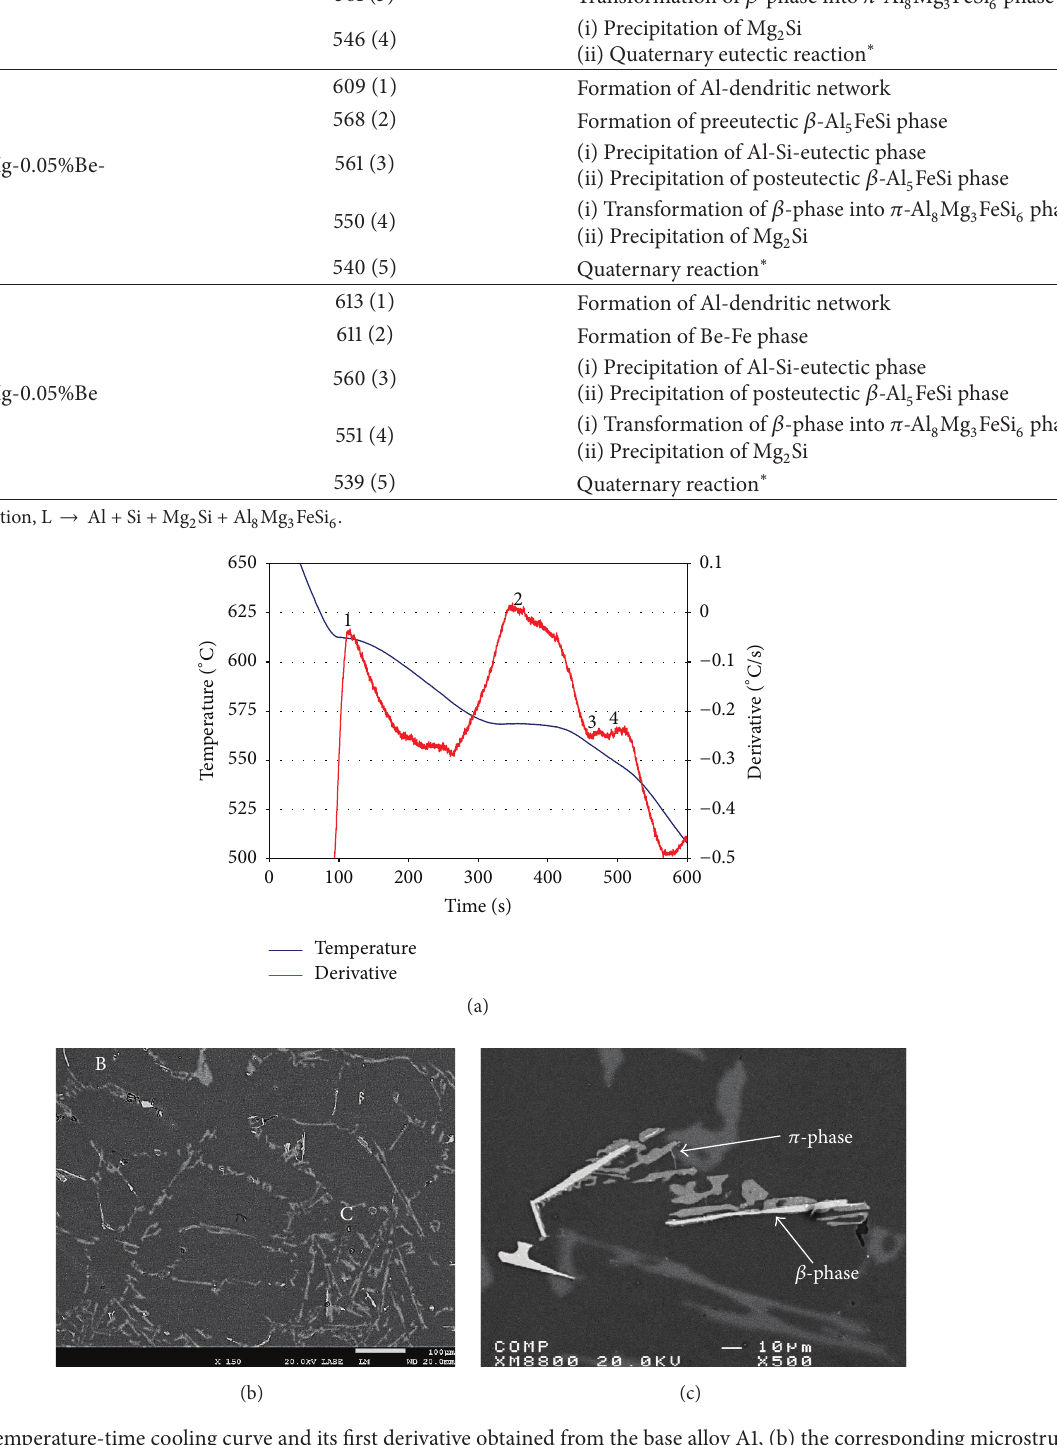
Figure 2: (a) Temperature-time cooling curve and its first derivative obtained from the base alloy A1, (b) the corresponding microstructure showing small size of the 𝛽 -Al 5 FeSi phase and the 𝜋 -Al 8 Mg 3 FeSi 6 phase particles, and (c) partial transformation of 𝛽 -Al 5 FeSi to 𝜋